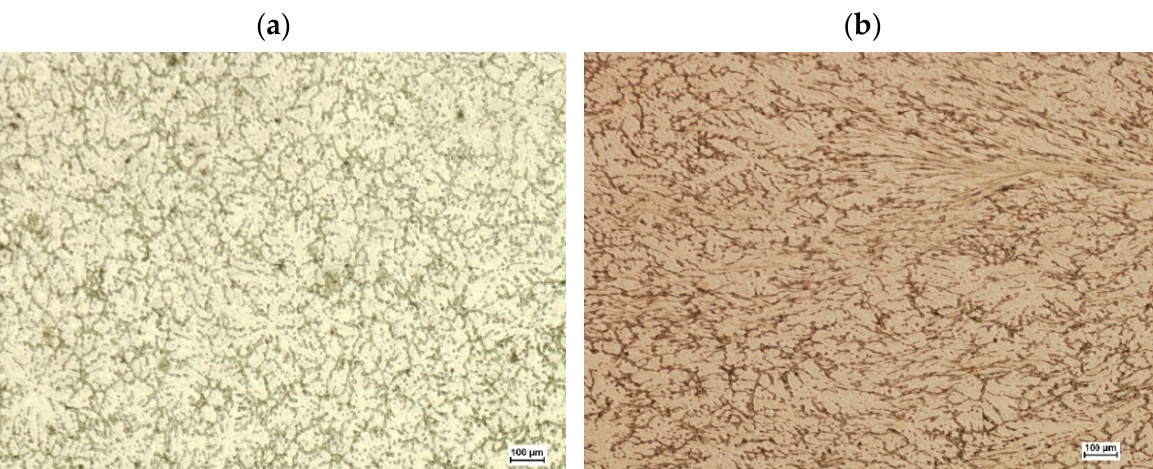
Figure 20. The disclosed microstructure of the sample with a circular cross-section in the area of the axis after plastic deformation: ( a )—sample without axial discontinuity; ( b )—sample with artificially introduced axial discontinuity.